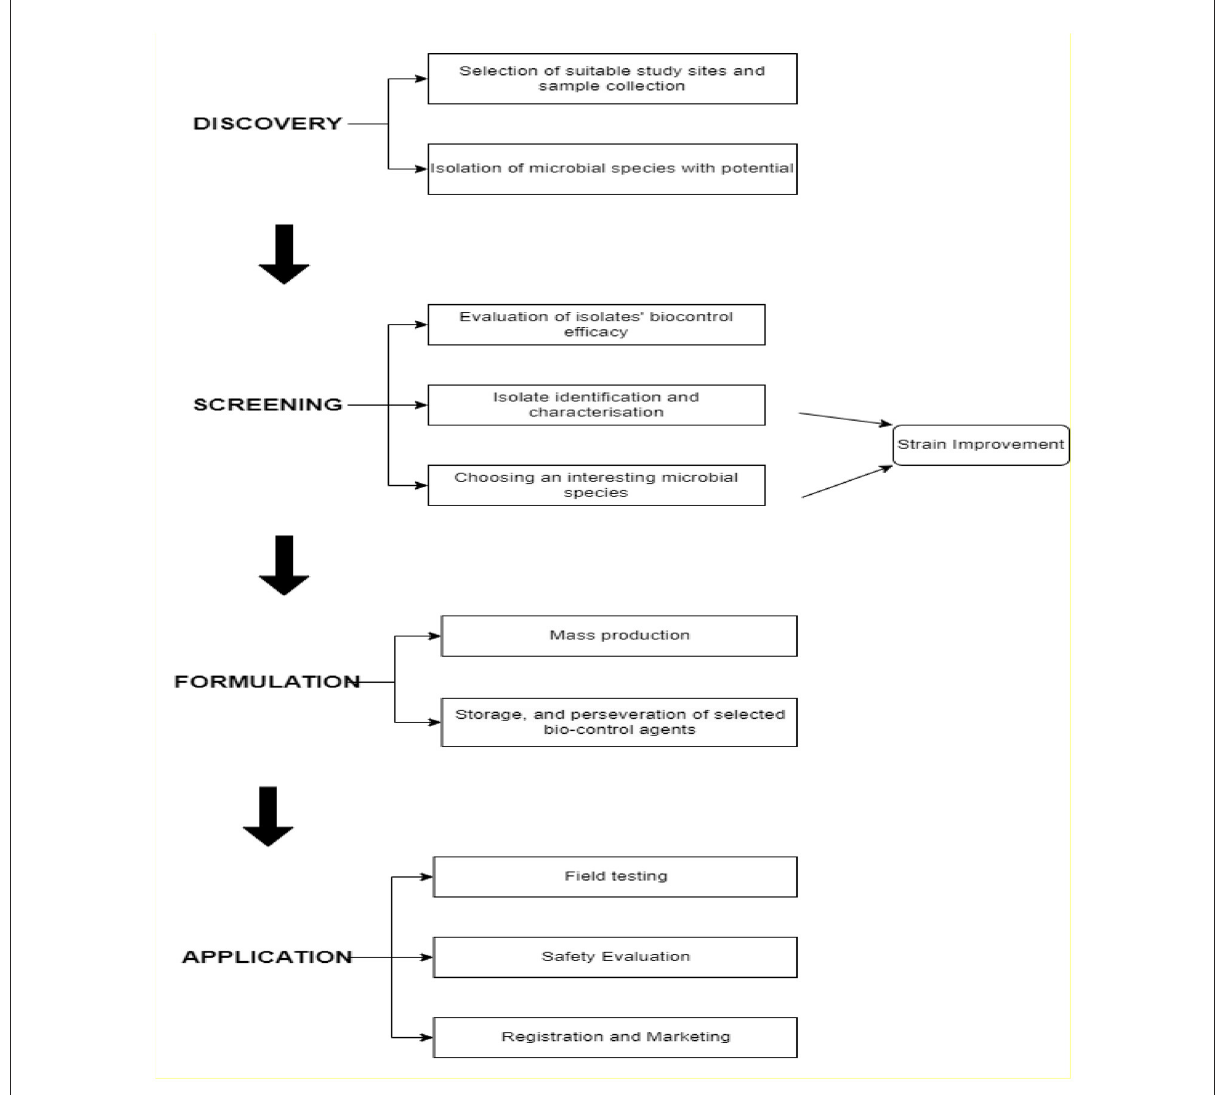
FIGURE2 Illustration of the process involved from discovery to application of potential microbial.